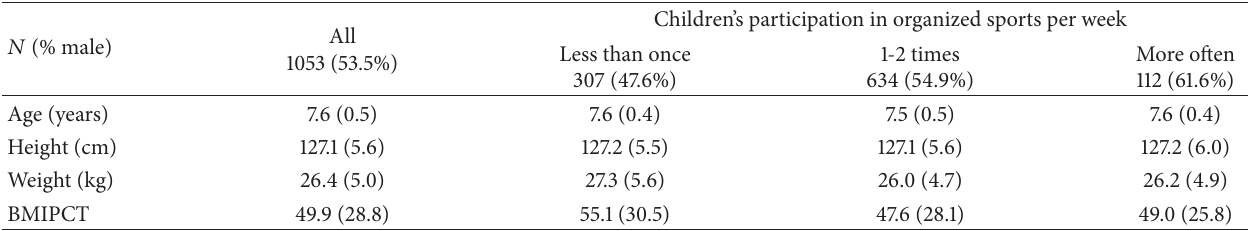
Table 1: Subjects characteristics of the total sample (all) stratified by participation in organized sports per week. Values are mean and SD. 𝑁 (% male)